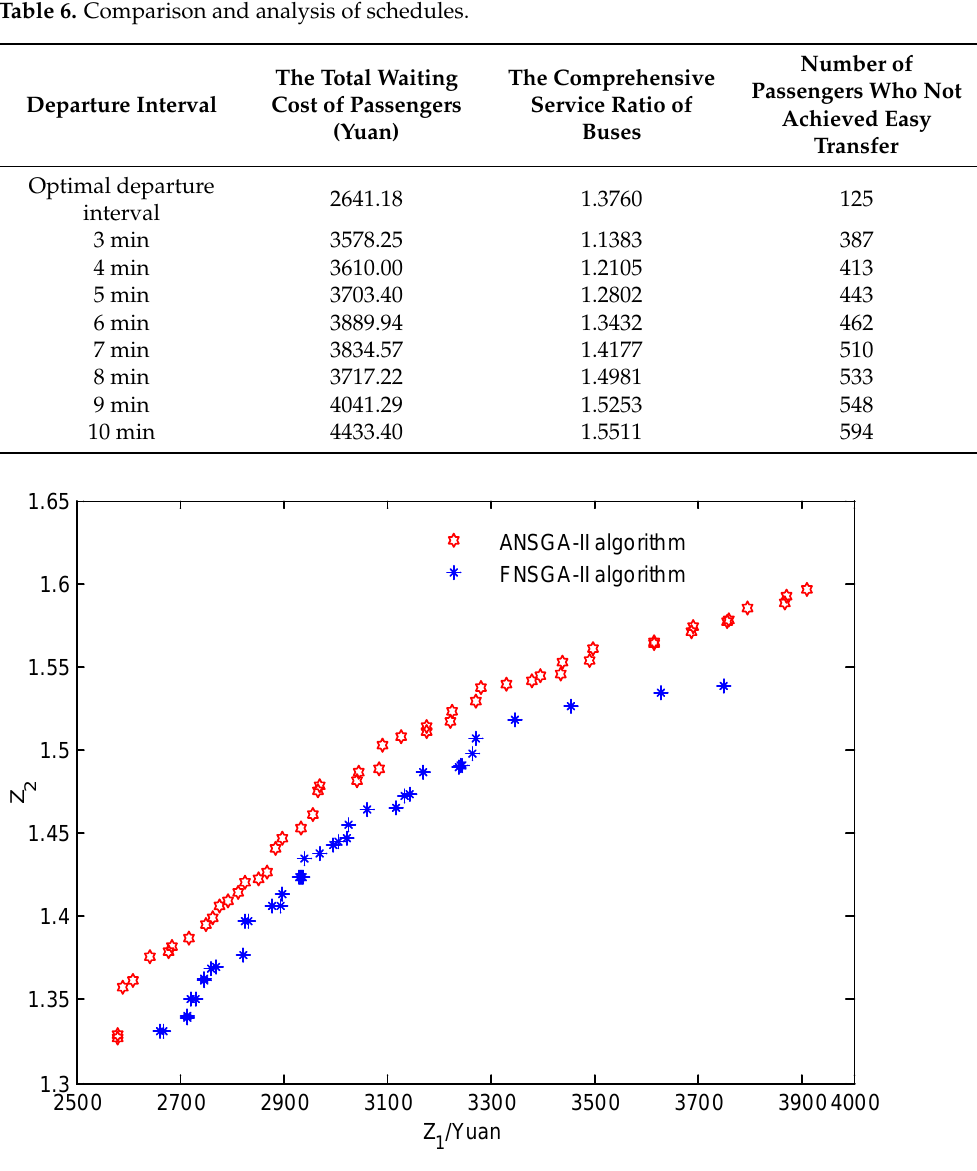
Figure 7. Comparison of calculation results for two algorithms.